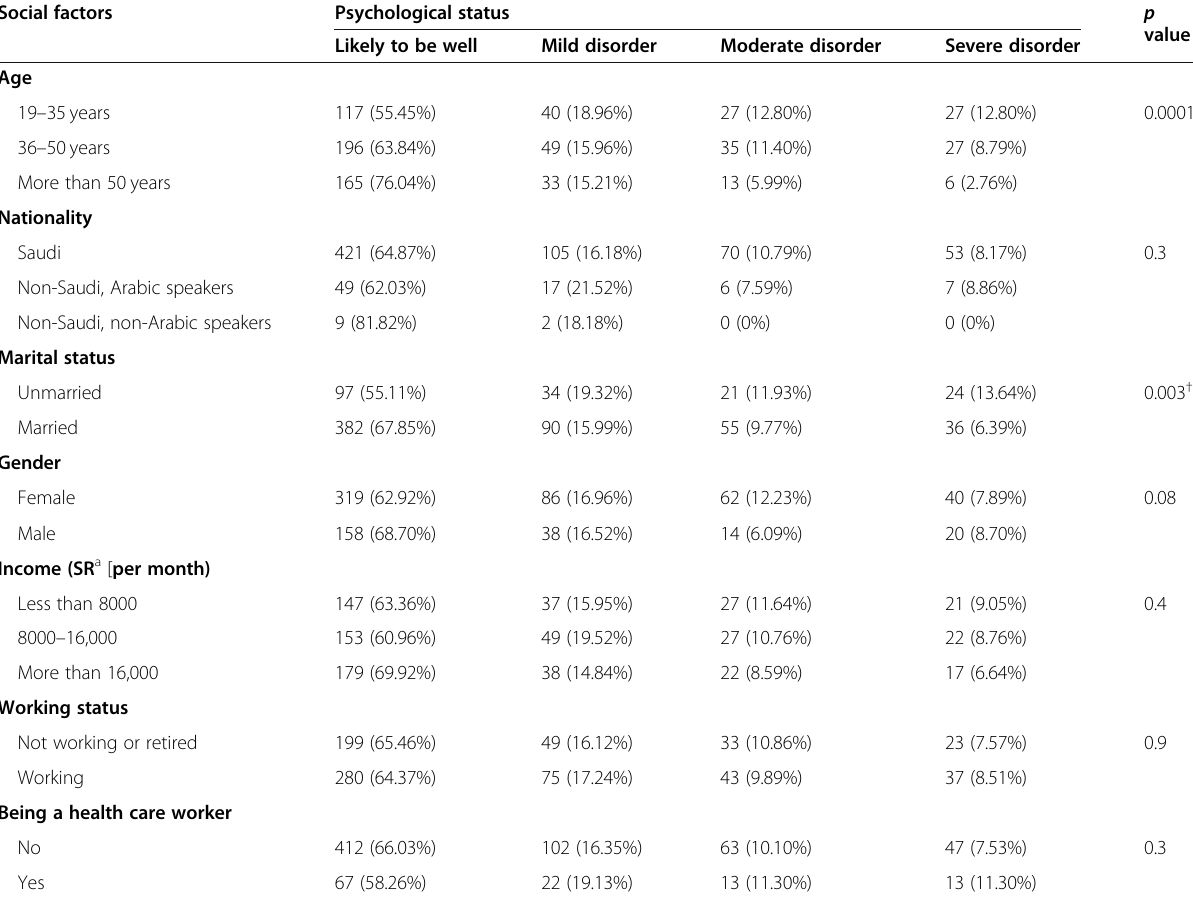
Table 2 Association between psychological distress and social factors among the population living in KSA Social